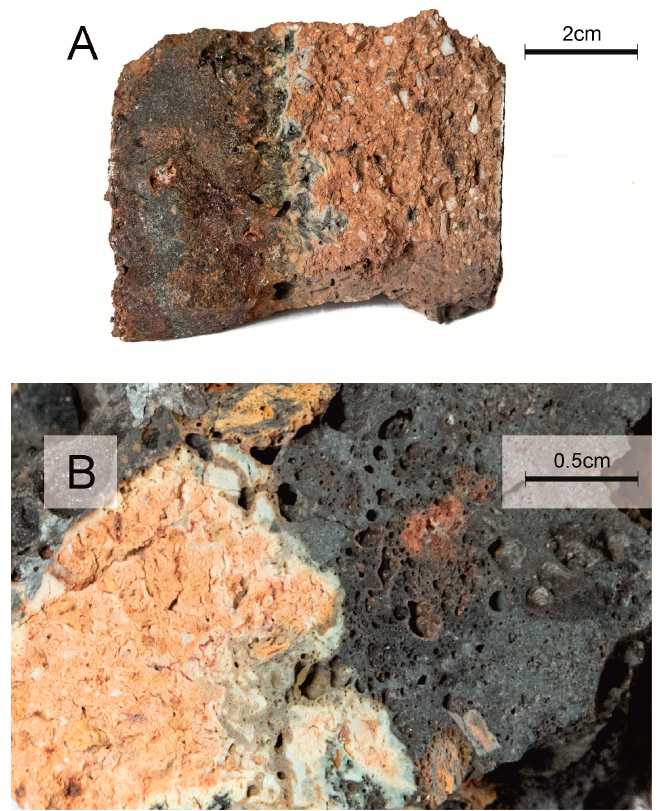
Figure 2. Macroscopic images of ( A ) representative slag sample and ( B ) its cross-section containing contact between slag (dark parts) and refractory materials (light parts).